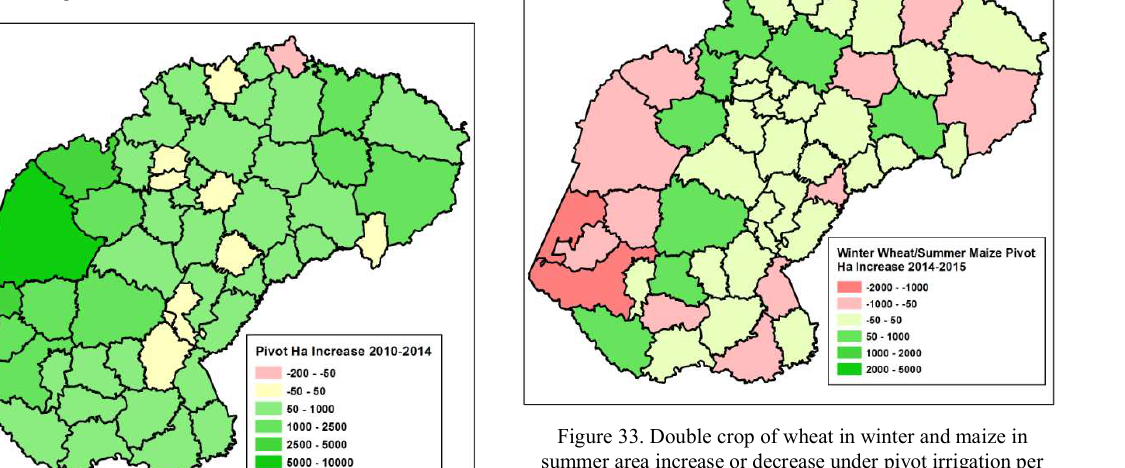
Figure 30. The percentage of all cultivated fields that are pivot irrigated per district for Freestate in 2014 From the figures above one can see that there was a slight increase of the percentage in area under pivot irrigation of all fields between 2010 and 2014 in certain districts in the western part of the province. This indicates an increasing preference for this method of crop production in those regions. The western regions of the Freestate are drier climatically, but having the significant Orange river flowing on the south western border which plays a vital role in agriculture in the region. The increase in Ha area of pivot irrigation for each district was calculated and displayed in Figure 31.